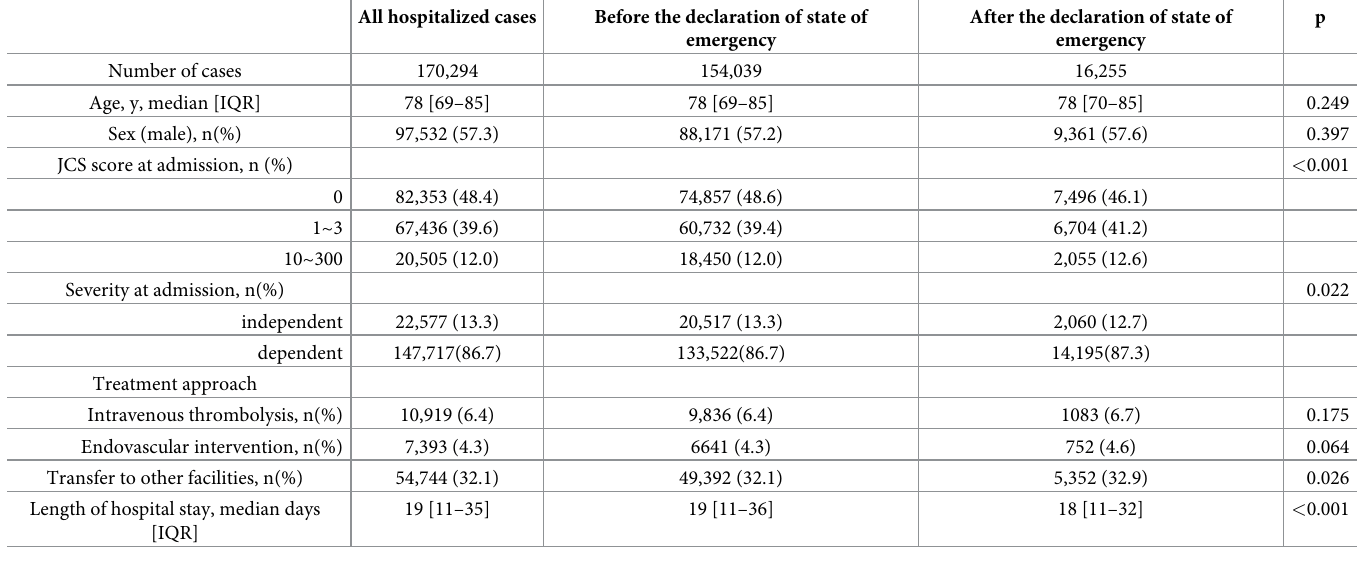
Table 1. The total number, characteristics, and time-sensitive treatment approaches of inpatient cases with ischemic stroke before and after the declaration of state of